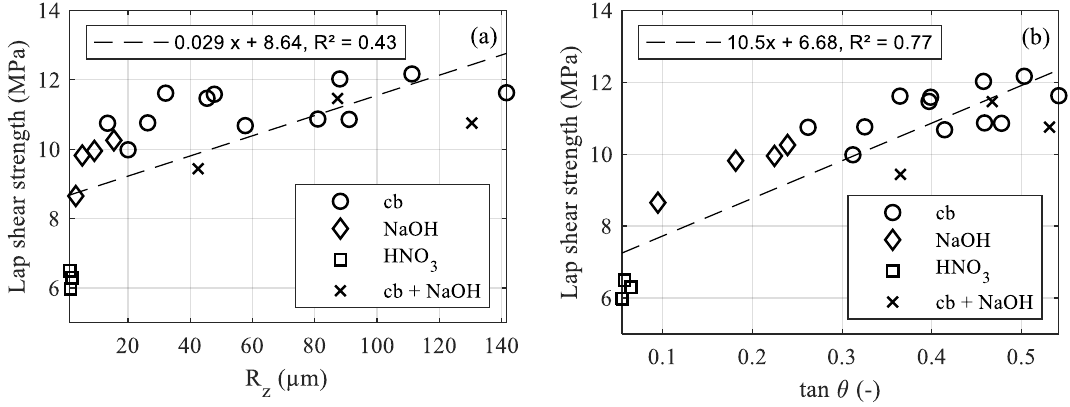
Figure 9. Lap shear strength ( a ) over R z and ( b ) over tan ɵ , both with a 5 µm tip diameter.